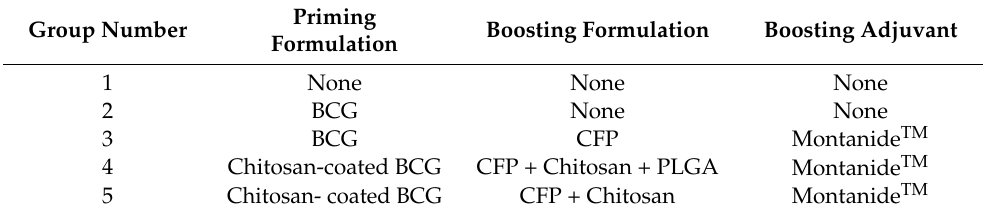
Table 1. Experimental groups to determine the efficacy of the BCG vaccine in different protocols of vaccination in a goat model. CFP: culture filtrate protein and PLGA: PolyLactic-co-Glycolic Acid. Priming Group Number Boosting Formulation Boosting Adjuvant Formulation 1 None None None BCG None None BCG CFP 4 Chitosan-coated BCG CFP + Chitosan + PLGA Chitosan- coated BCG CFP + Chitosan Montanide